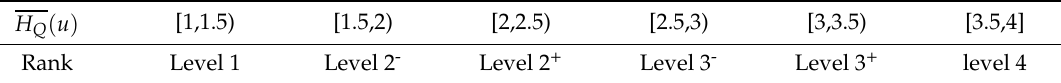
Table 4. Judgment criteria for the consequences